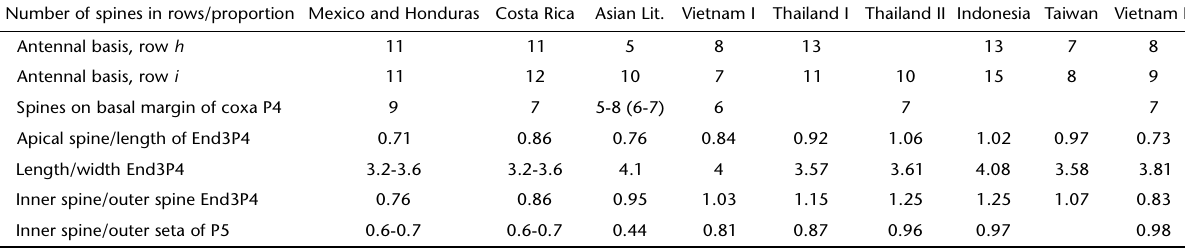
Table I. Variation of the appendage ornamentation and other morphological characters among different populations of Mesocyclops thermocylopoides . Characters of Asian Lit. based on H ARADA (1931), H OLYNSKI & F IERS (1994), and H OLYNSKA et al. (2003). Mexico and Honduras specimens from G UTIÉRREZ -A GUIRRE & S UÁREZ -M ORALE s (2001), S UÁREZ -M ORALES & G UTIÉRREZ -A GUIRRE (2001) and ECO-CHZ-1181, Costa Rican specimens from C OLLADO et al. (1984), and specimens from El Arenal. Vietnam I from Hai Hung, Vietnam (USNM 271930). Vietnam II from Sword Lake, Hanoi, Vietnam (USNM 251632). Thailand I and Thailand II from Chachoengsao, Thailand (USNM 271905, USNM 271904). Indonesia from undetermined locality in Indonesia (USNM 264006), Taiwan from Bao-Shan Reservoir, Hsin-chu, Taiwan (USNM 1083794). (P4) Fourth swimming leg, (End3P4) third endopodal segment of fourth swimming leg. Number of spines in rows/proportion Mexico and Honduras Costa Rica Asian Lit. Vietnam I Thailand I Thailand II Indonesia Taiwan Vietnam II Antennal basis, row h Antennal basis, row i Spines on basal margin of coxa P4 Apical spine/length of End3P4 0.71 Length/width